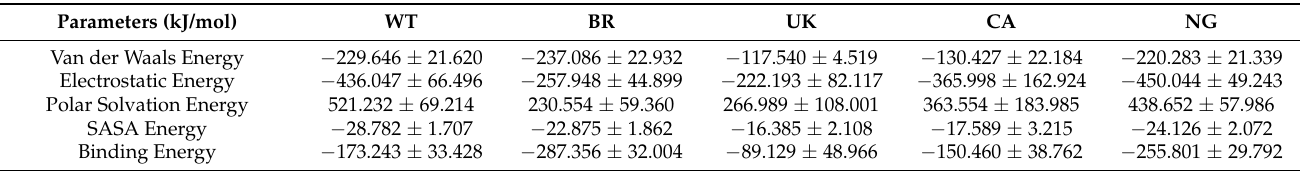
Table 4. Results of the MM-PBSA interaction energy (kJ/mol) calculations for bromelain-derived peptide-RBD/WT, BR, UK, CA, and NG variant